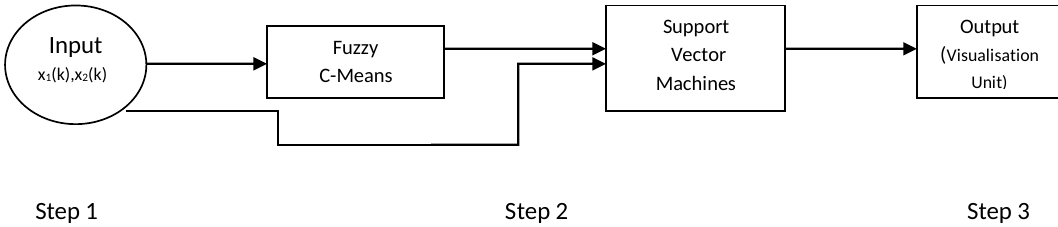
Figure 3. Block scheme for FCM-based